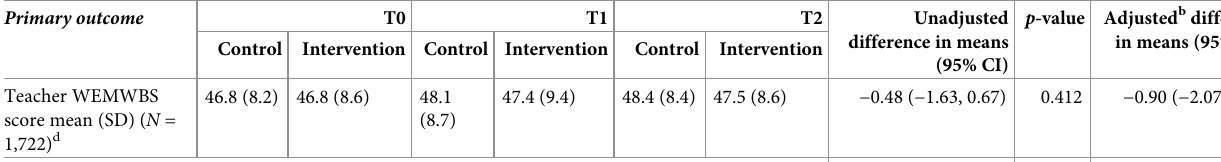
Table 2. Results for primary and secondary outcomes a